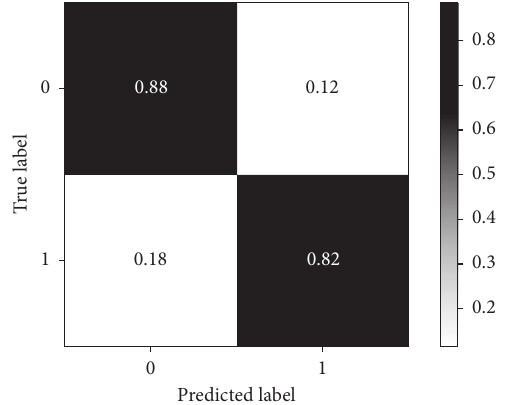
Figure 3: Confusion matrix for testing data using KNN model.